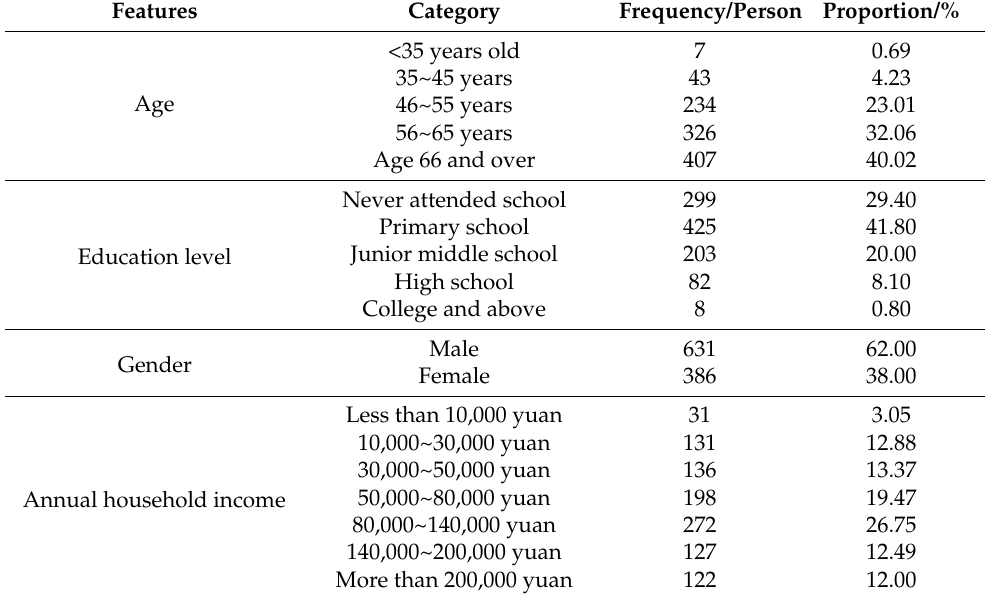
Table 1. Essential characteristics of sample farmers in the study